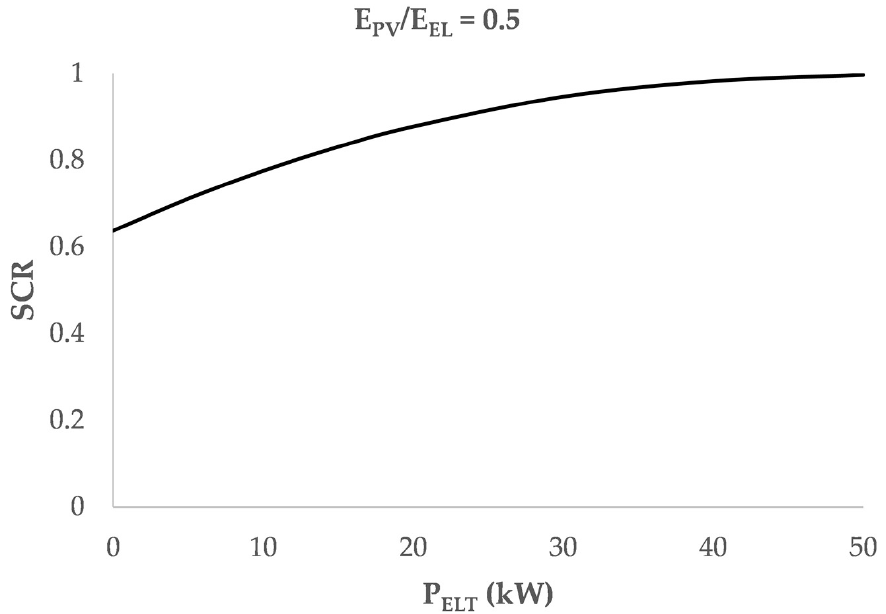
Figure 3. SCR versus the rated power of electrolyser in the scenario E PV /E EL equal to 0.5.